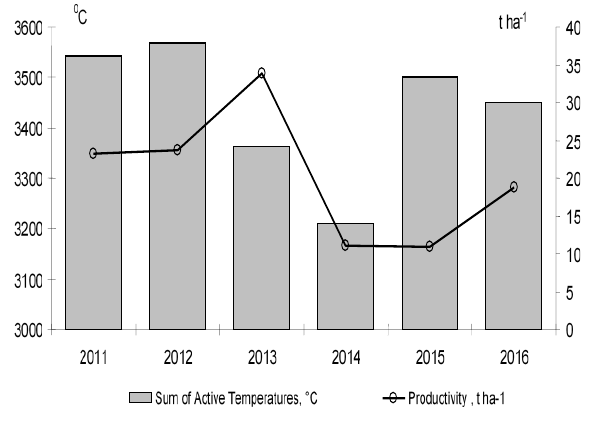
Figure 1 . Influence of SAT on lovage productivity during the years 2011-2016.